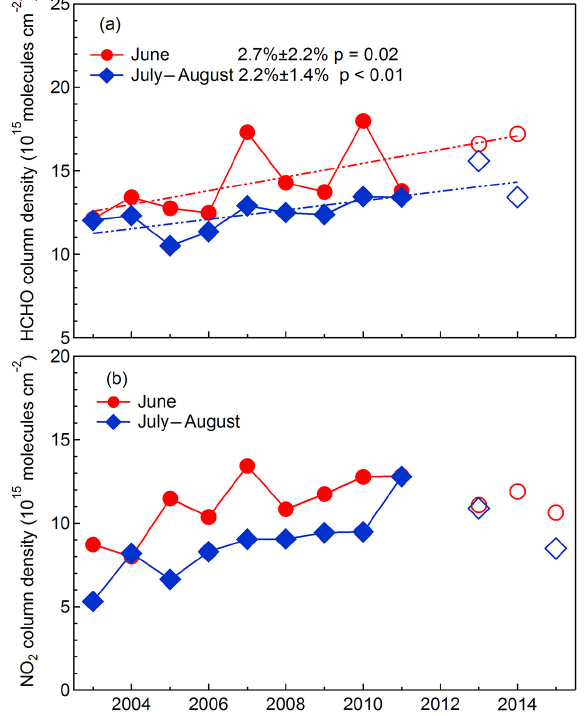
Figure 9. Monthly average column density of (a) formaldehyde and (b) NO 2 retrieved from SCIAMACHY (2003–2011; solid markers) and GOME-2(B) (2013–2015; open markers) for the target domain (32–38 ◦ N, 115–120 ◦ E). For formaldehyde, the fitted lines are de- rived from the least square linear regression analysis with the slopes ( ± 95% confidence intervals) and p values also